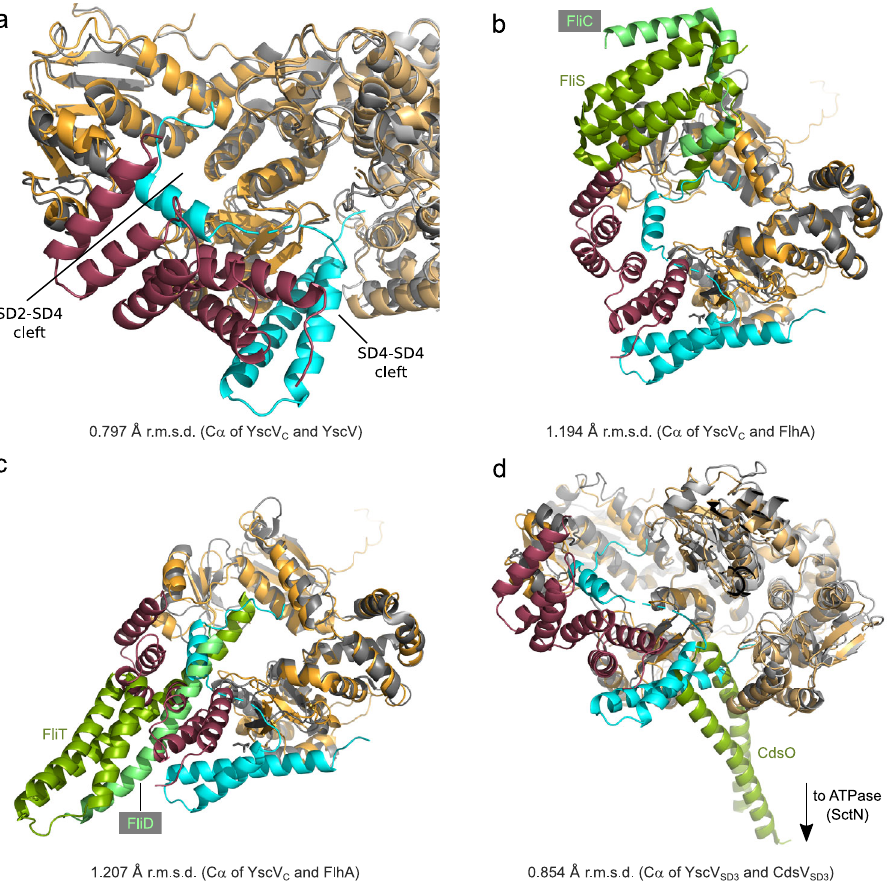
Fig. 9 Superposition of export gate complexes with YscVXY. YscV, YscX, and YscY are shown in orange, cyan, and red, respectively. a Superposition with the cryo-EM structure of YscV C (gray, PDB: 7ALW), which is shown as cartoon representation. YscV C protomers are aligned with an r.m.s.d. of 0.797 Å. b , c Superposition with FlhA (gray) bound to the fl agellar chaperone:substrate complexes (green:light green). b FlhA:FliS:FliC (PDB: 6CH3). c FlhA:FliT:FliD (PDB: 6CH2). Alignments were obtained using SD3 of YscV C (residues 514 – 600) with an r.m.s.d. of 1.194 Å (PDB: 6CH2) and 1.207 Å (PDB: 6CH3). d YscVXY superimposed with Chlamydia pneumoniae CdsV in complex with the stalk protein CdsO (PDB: 6WA9). The alignment was calculated using SD3 of YscV C with an r.m.s.d. of 0.854 Å. Two subunits of YscV and CdsV (gray) are shown, CdsO is colored in and 1mM dithiothreitol. To remove the MBP-tag of YscX, 1mg of TEV-protease onto 5mL amylose resin to remove the remaining MBP-tagged protein. The fl ow- was added per 50 mg of target protein and the resin was incubated at 20°C over through and washing fractions were combined, concentrated, and puri fi ed via size night on a seesaw shaker. The fl ow-through and successive washing fractions were exclusion chromatography on a HiLoad 16/60 Superdex 200 pg (Cytiva). Before collected, pooled and imidazole was added to a fi nal concentration of 15mM before freezing the concentrated protein complex, 5mM TCEP was added. being loaded onto 5mL of NiNTA resin (Protino Ni-NTA Agarose, Macherey- Nagel). After 60min of incubation, unbound protein was washed from the column by increasing the imidazole and NaCl concentrations to 100 and 300 mM, respectively. YscX:YscY eluted from the resin when adding elution buffer (20 mM Tris pH 8, 150 mM NaCl, 250 mM imidazole, 1mM DTT). Finally, the protein was puri fi ed